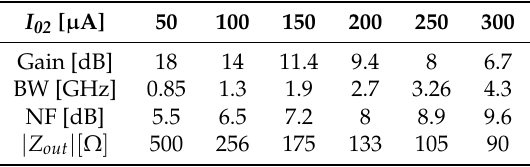
Table 1. Summary of measured results with I 01 = 550 µ A and V DC = ± 1.5 V.